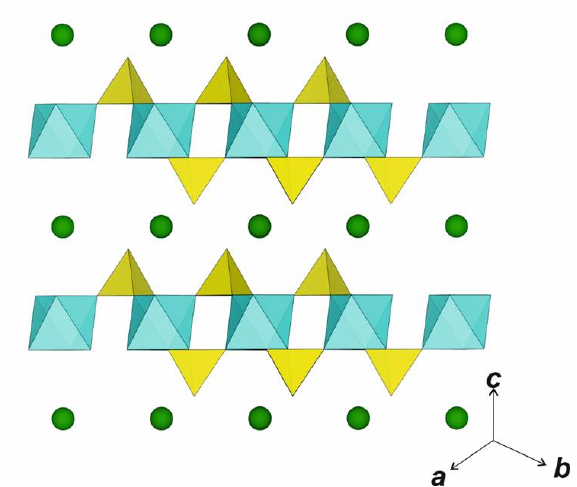
Figure 2. The crystal structure of steklite, KAl(SO 4 ) 2 . SO 4 tetrahedra are yellow, AlO 6 octahedra are blue, and K atoms are green circles.